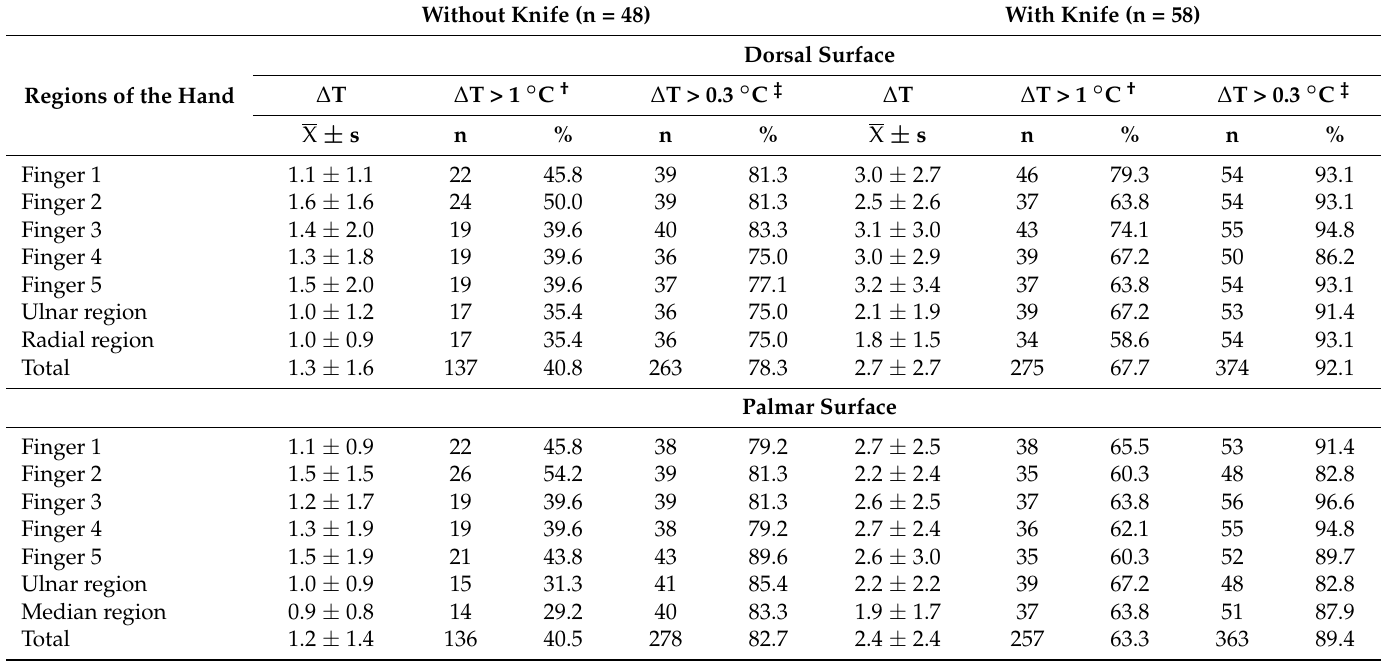
Table 2. Differences between temperature averages of the right and left hands of the two groups. Without Knife (n = 48) With Knife (n =